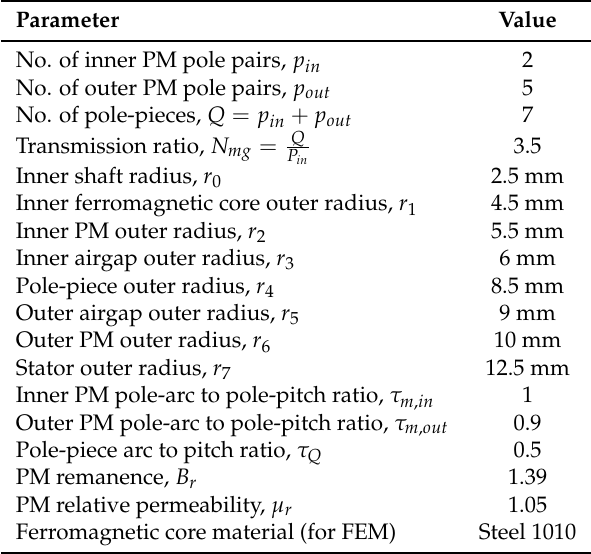
Table 5. Magnetic gear parameters for the model